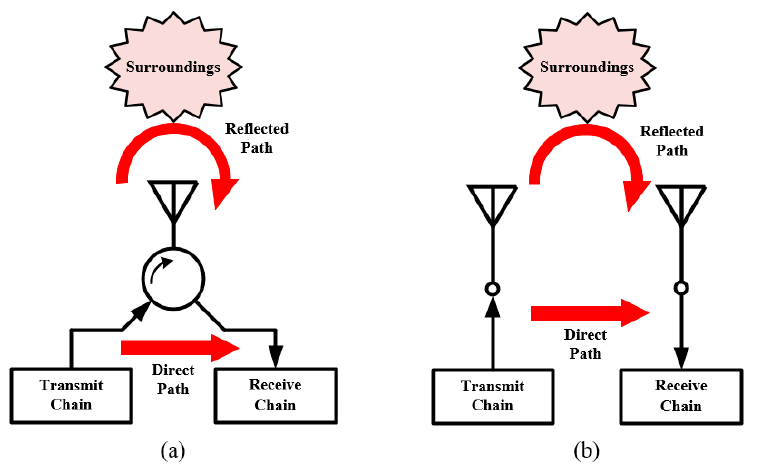
Figure 15. Two types of self ‐ interference in IBFD communication with ( a ) single/shared antenna and ( b ) multiple antennas. ( b ) multiple